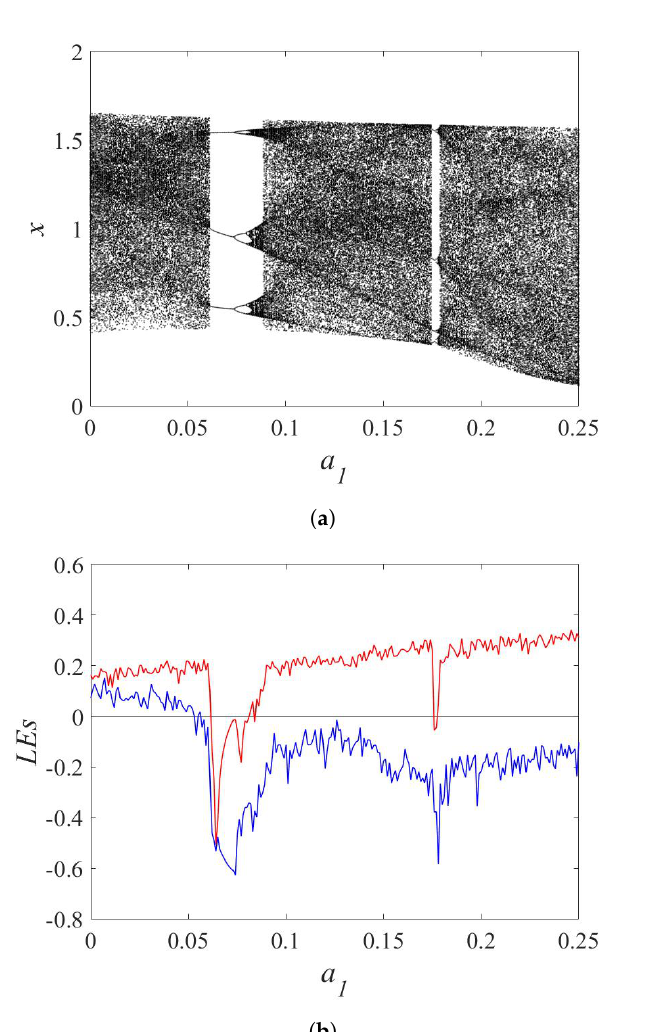
Figure 5. By changing a 1 of the FPFM 1 map from 0 to 0.25 we get ( a ) bifurcation diagram, ( b ) Lyapunov exponents, where the red and blue curves present the first and second Lyapunov exponents,